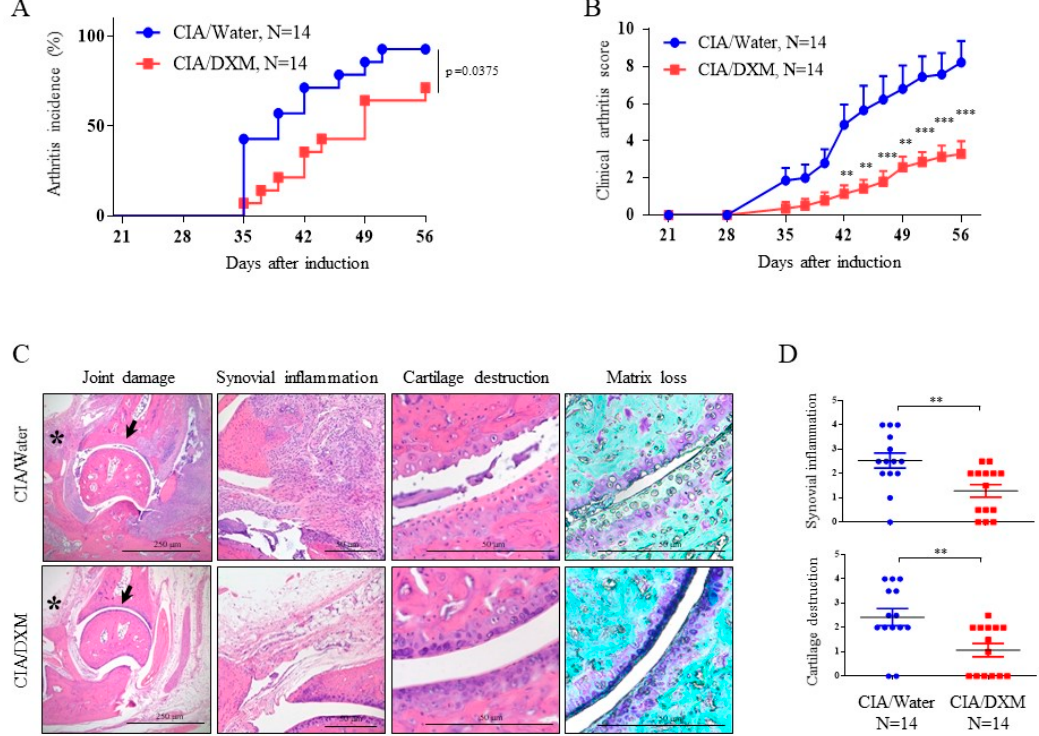
Figure 6. DXM delayed disease onset and severity in collagen-induced arthritis (CIA). Arthritis incidence ( A ) and total clinical arthritis score ( B ) were measured during the observation period of DXM (40 mg/kg/day)-treated CIA mice ( n = 14) or water-treated CIA mice ( n = 14). ( C ) Histological analysis of the joints of CIA mice treated with DXM or water were performed by hematoxylin and eosin (H&E) staining (original magnification, ×40 and ×200) and toluidine blue staining (original magnification, ×200) of the ankle joints. The asterisks point to the area of synovium and the arrows indicate the cartilage. ( D ) The histopathology scores on synovial inflammation and cartilage destruction were quantitatively analyzed. Values are the means ± S.E.M. and significance (** p < 0.01; *** p < 0.001) was analyzed by Kaplan–Meier log-rank analysis ( A ), two-way ANOVA ( B ), and the Mann-Whitney U test ( D ).